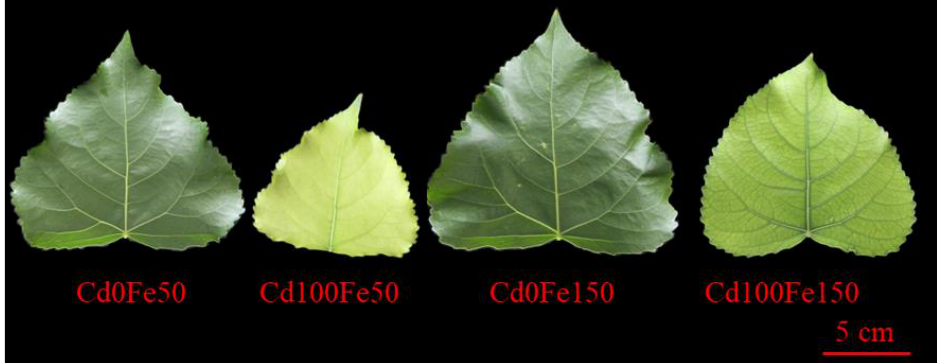
Figure 1. The leaves of poplar under different Cd and Fe combined treatments. Cd0Fe50: 0 μM CdCl 2 + 50 μM FeCl 3 ; Cd0Fe150: 0 μM CdCl 2 + 150 μM FeCl 3 ; Cd100Fe50: 100 μM CdCl 2 + 50 μM FeCl 3 ; Cd100Fe150: 100 μM CdCl 2 + 150 μM FeCl 3. The same below.